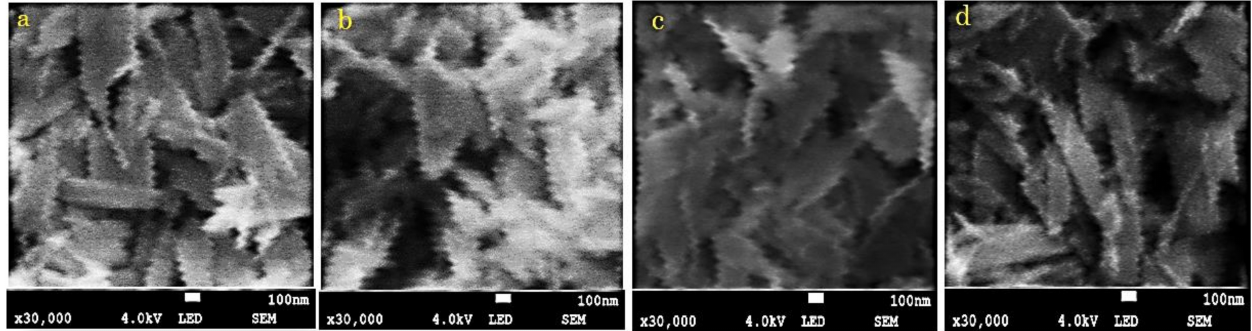
Figure 3. SEM images of CuO nanocoatings ( a ) 700 rpm, ( b ) 800 rpm, ( c ) 900 rpm, and ( d ) 1000